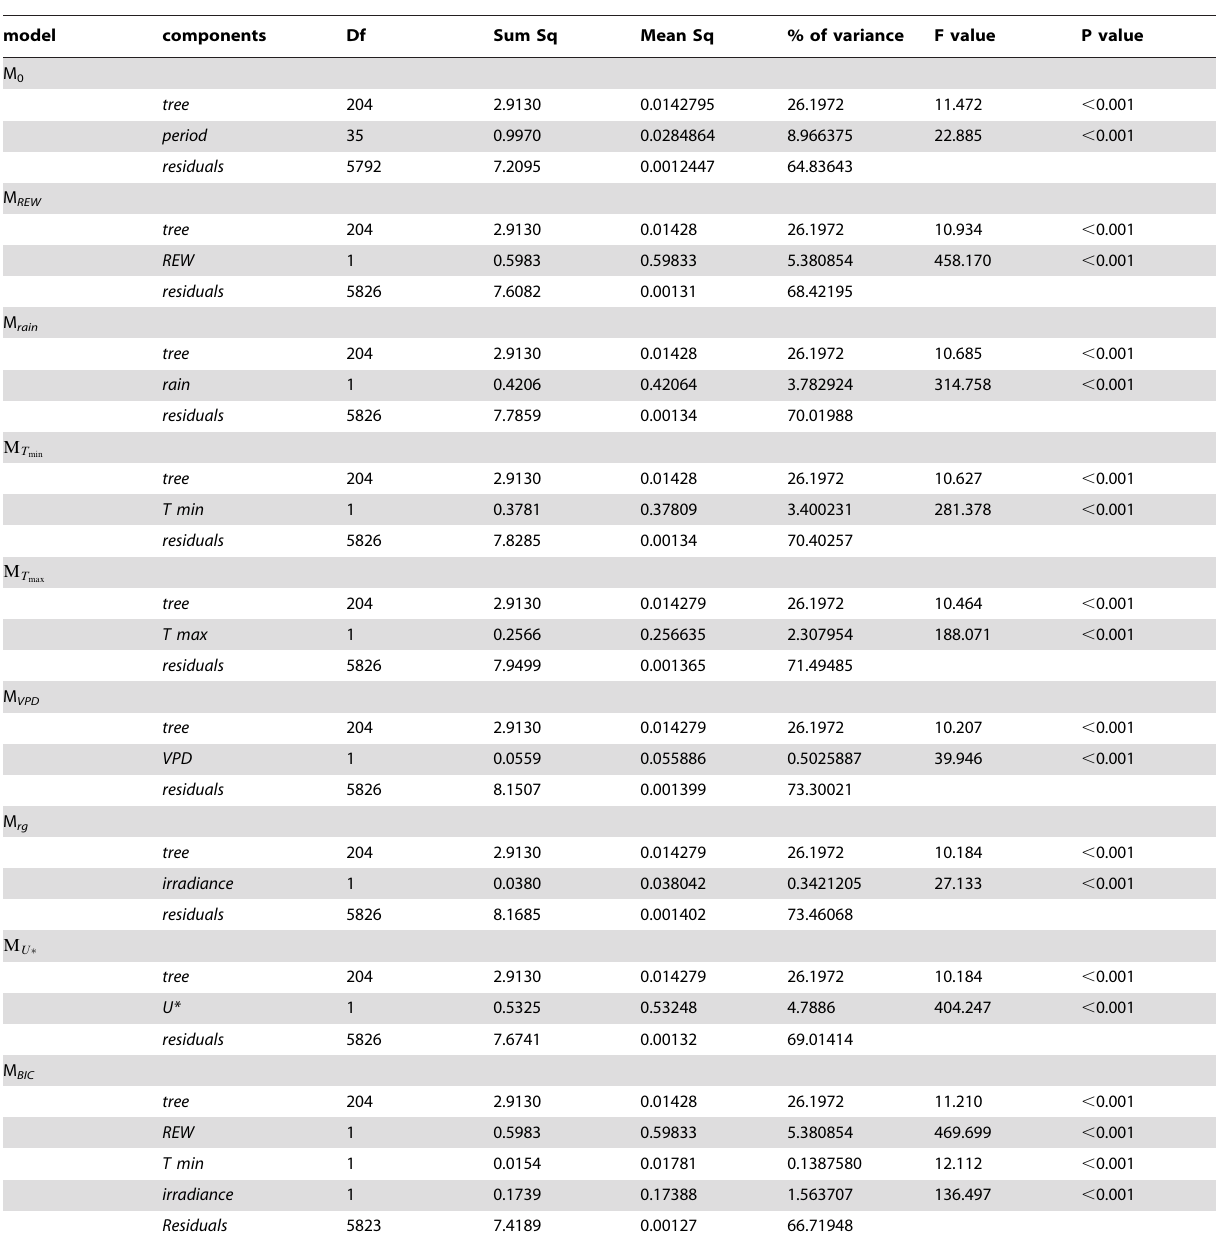
Table 3. Variance decomposition of the univariate